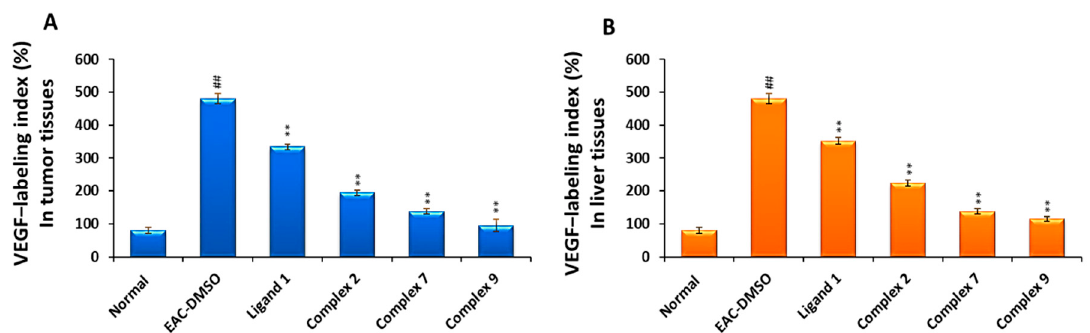
Figure 2. Effect of ligand 1 and its metal complexes 2 , 7 and 9 on vascular endothelial growth factor (VEGF) expression in tumor tissues ( A ) and in liver tissues ( B ) of Ehrlich ascites carcinoma (EAC)-bearing mice. VEGF expression was determined by immunohostochemistry assay. VEGF expression was expressed as labeling index percentage. Data are expressed as mean ± SEM. Significantly (## p < 0.01) different from the normal mice and significantly (** p < 0.01) different from mice bearing solid tumor treated with vehicle (DMSO).